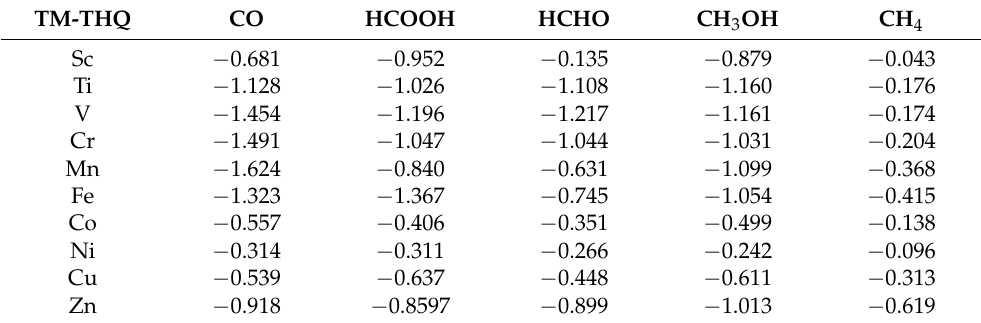
Figure 5. Flow chart of electrocatalytic CO 2 reduction to C 1 product scheme; red is the final product [43]. Table 2. Adsorption energies ( E ads / eV ) with different reduced carbon dioxide